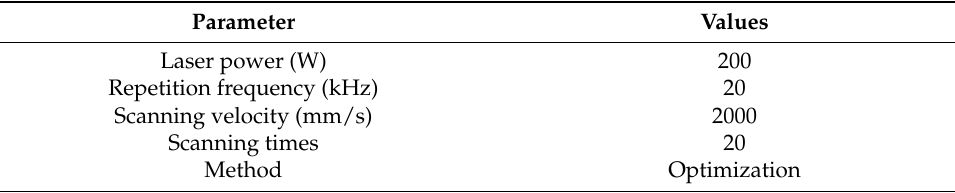
Figure 2. Schematic diagram of experimental setup for laser degumming. Table 1. Experimental parameters.